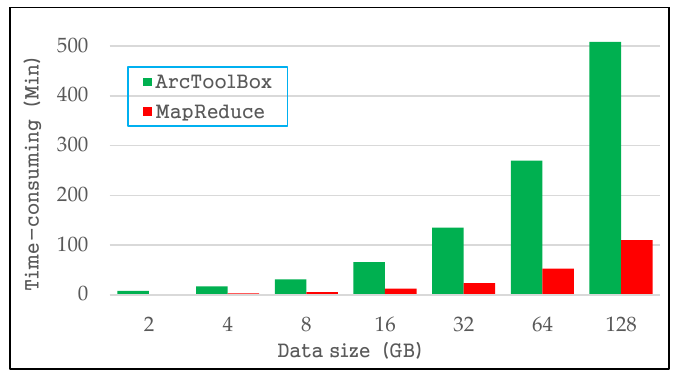
Figure 8. The time-consuming comparison of data conversion in a stand-alone environment.